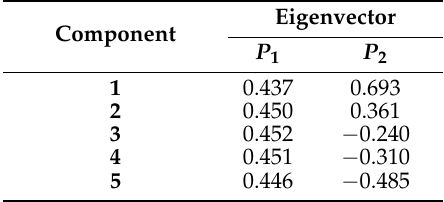
Table 4. Eigenvectors associated with the first two principal